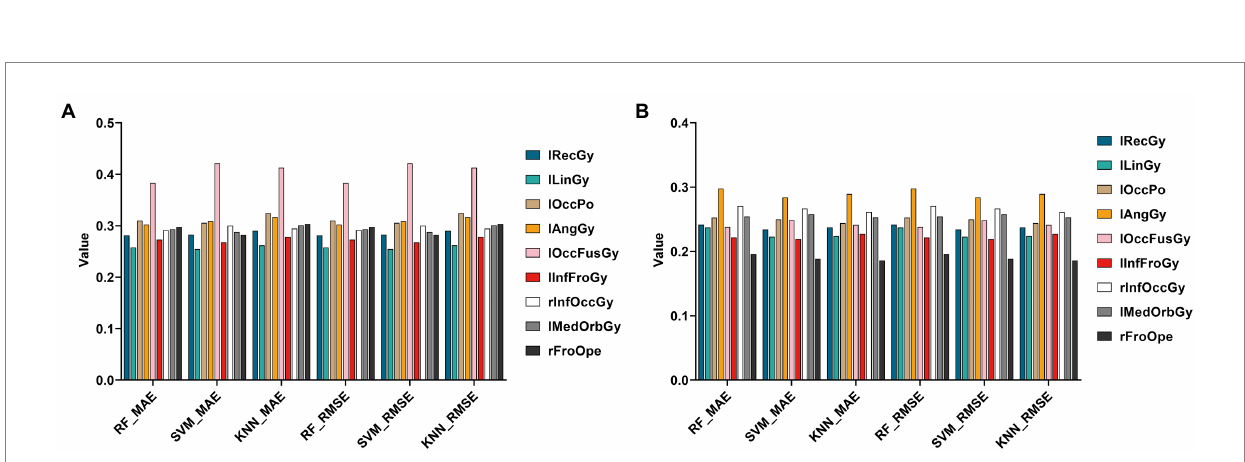
FIGURE 11 Histograms of errors (MAE and RMSE) obtained by regression prediction of Top 10 ROIs using Top10 genes in the AD and MCI groups, respectively. (A,B) Are the regression results of two groups,